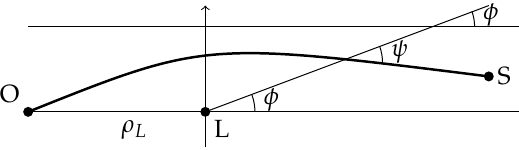
Figure A2. Schematic definition of the angle ψ , defined in Equation (A8). See also Figure 2 of Ref.